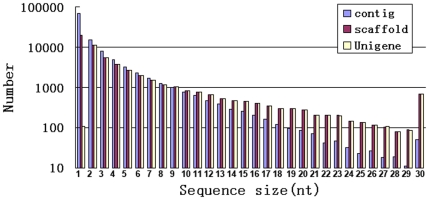
Statistics of Illumina short read assembly quality.The length distribution of the de novo assembly for contigs, scaffolds and Unigenes is shown. 1, 200; 2, 300; 3, 400; 4, 500; 5, 600; 6, 700; 7, 800; 8, 900; 9, 1,000; 10, 1,100; 11, 1,200; 12, 1,300; 13, 1,400; 14, 1,500; 15, 1,600; 16, 1,700; 17, 1,800; 18, 1,900; 19, 2,000; 20, 2,100; 21, 2,200; 22, 2,300; 23, 2,400; 24, 2,500; 25, 2,600; 26, 2,700; 27, 2,800; 28, 2,900; 29, 3,000; 30, >3,000.